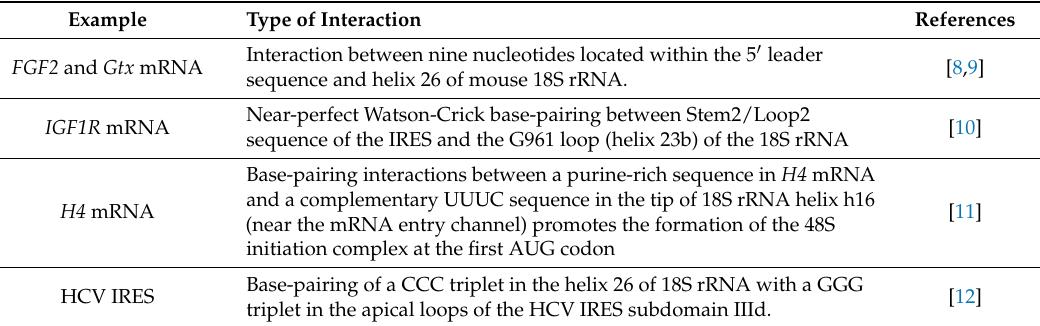
Table 1. Examples of ribosomal-messenger RNA (rRNA-mRNA) base